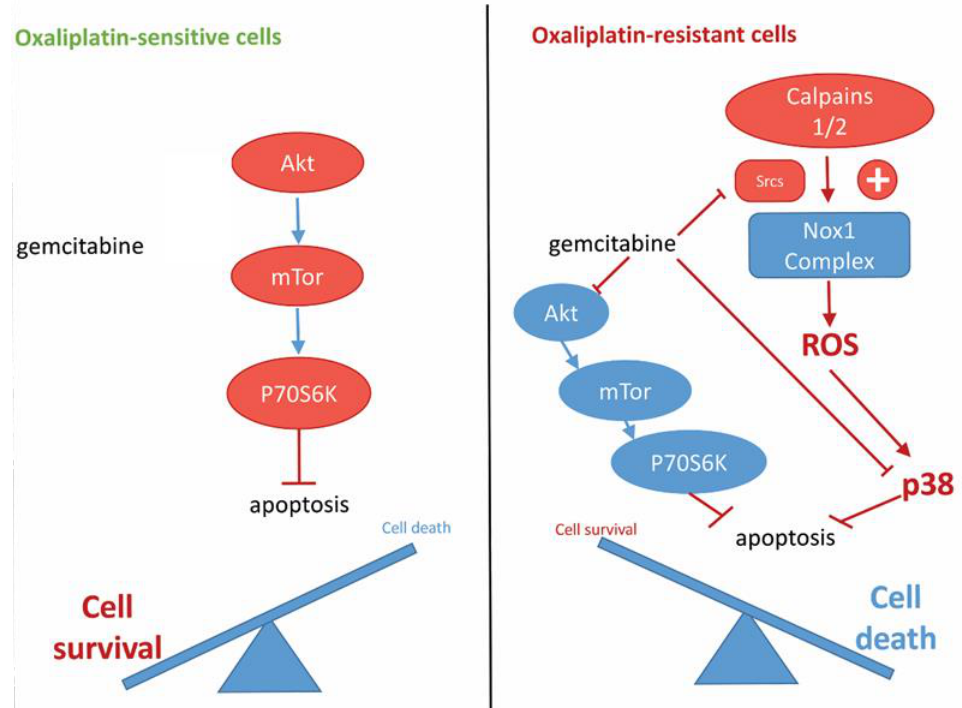
Figure 5. Proposed model for the mechanism of action of gemcitabine in oxaliplatin-resistant cells. Supplementary Materials: The following supporting information can be downloaded at: